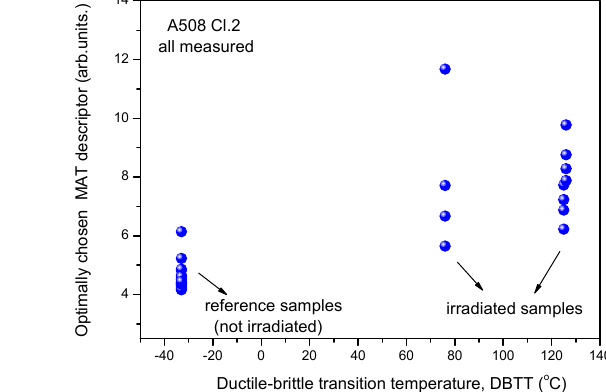
Figure 4. Dependence of the amplitude of third harmonics P3 parameter of 3MA as a function of transition temperature for all measured 15kH2NMFA and A508 Cl.2 samples. Figure 5. MBN RMS parameter as a function of transition temperature for all measured 15kH2NMFA and A508 Cl.2 samples.